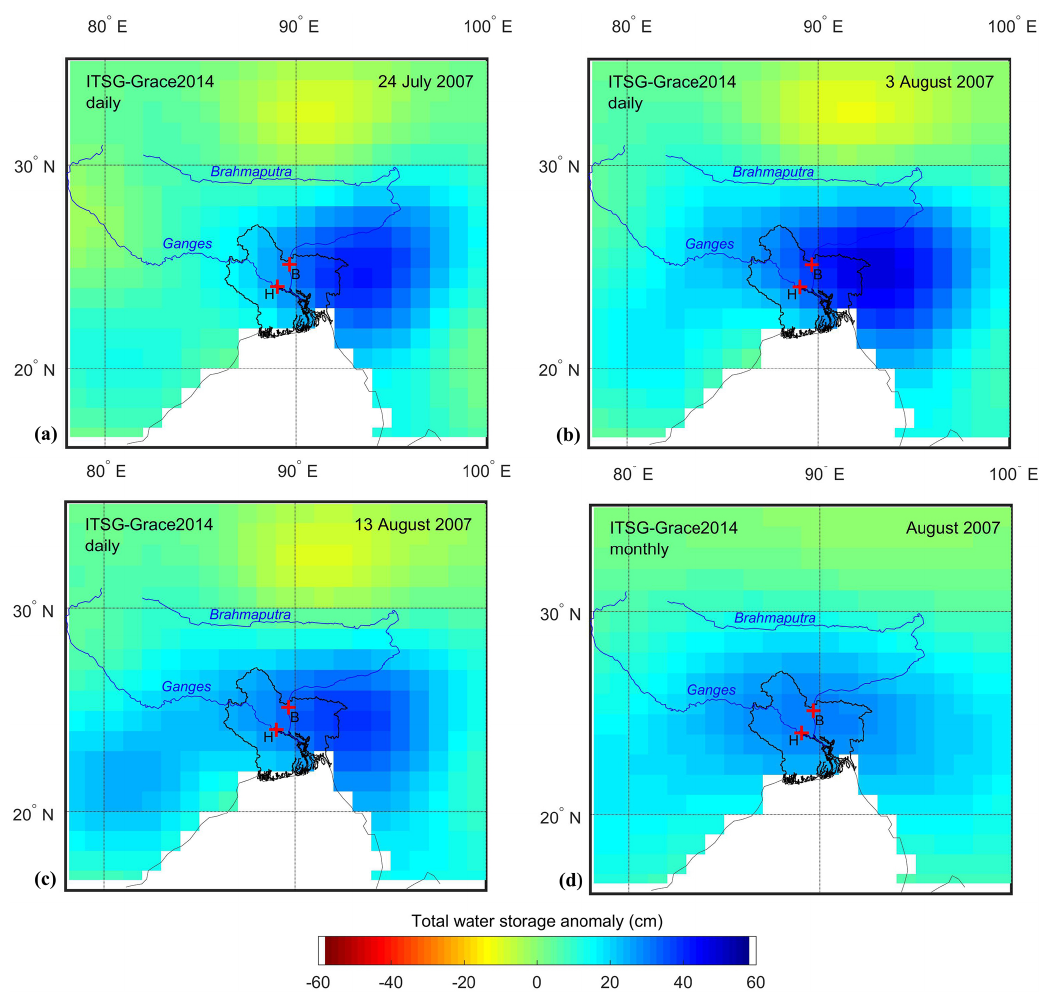
Figure 5. Daily and monthly water storage anomalies of the ITSG-Grace2014 solution for the Ganges–Brahmaputra Delta on (a) 24 July 2007, (b) 3 August 2007, (c) 13 August 2007 and (d) August 2007. Key is as in Fig.